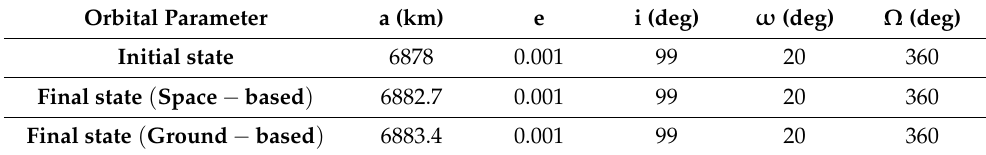
Table 8. Initial and final orbital parameters of the spacecraft after collision avoidance manoeuvres.